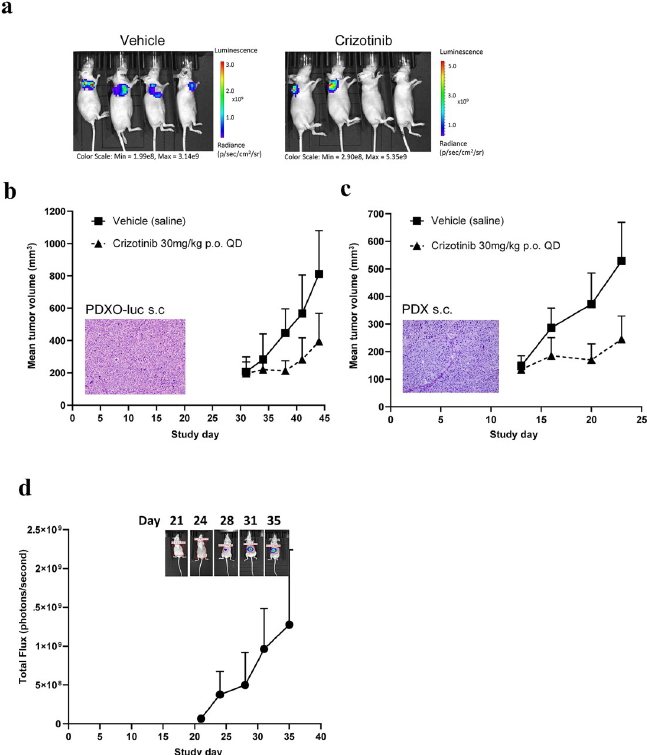
Fig 4. Organoid engineering enables luciferase tagging of PDXOs for real-time tracking. a) In vivo subcutaneous imaging of LI6664-luc PDXO to confirm tumorigenicity of engineered organoid and bioluminescent signal of construct; b) Subcutaneous LI6664-luc PDXO xenograft morphology (H&E, 20x magnification) and therapeutic response to crizotinib (mean tumor volume ± SEM, 30mg/kg p.o. daily crizotinib dose regimen) compared to original subcutaneous LI6664 PDX and c) Real-time optical imaging (mean total flux ± SEM) of orthotopic LI6664-luc PDXO implanted in the liver to determine growth kinetics in the liver with representative mouse image for each day of imaging (ventral